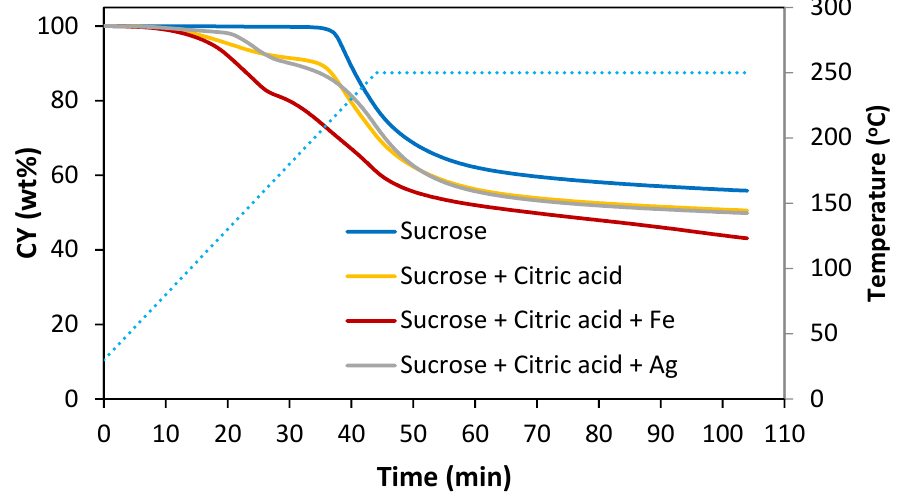
Figure 3. Weight loss curves of sucrose without and with additives in a dynamic step from 30 to 250 °C followed by an isothermal step of 60 min in a controlled air environment.